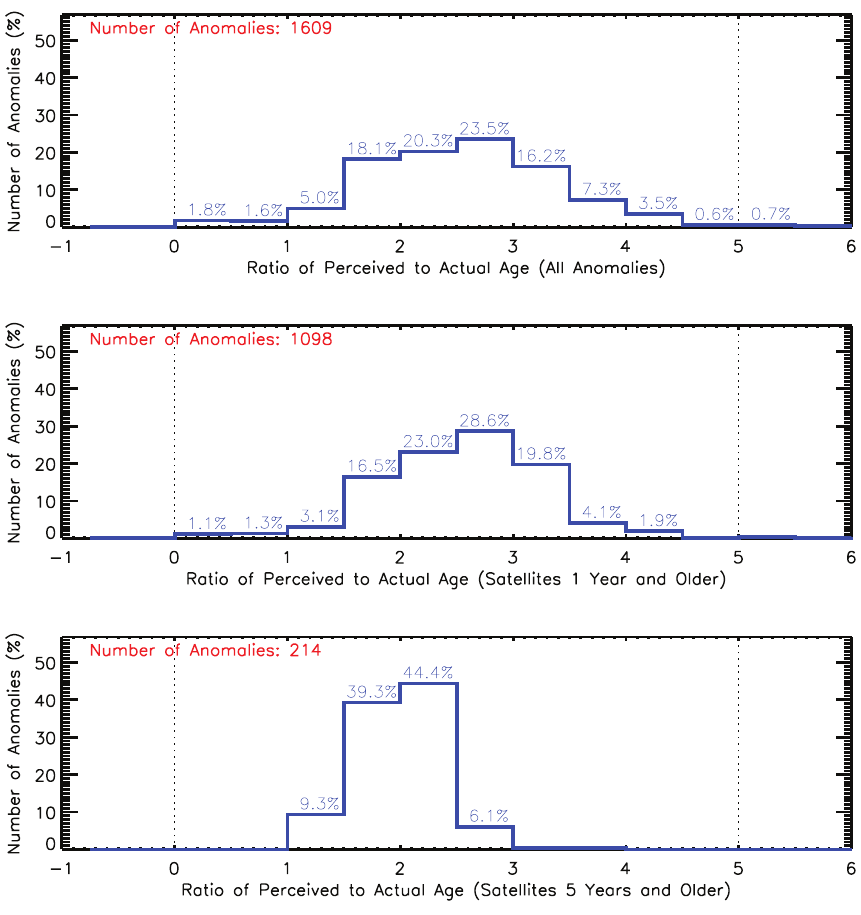
Fig. 4. Distributions of the greatest ratio of perceived age to chronological age. The top frame includes all anomaly events, while the middle frame includes only events where the satellite was one year old or older at the time the event occured, and the bottom frame includes only satelites that were 5 years old and